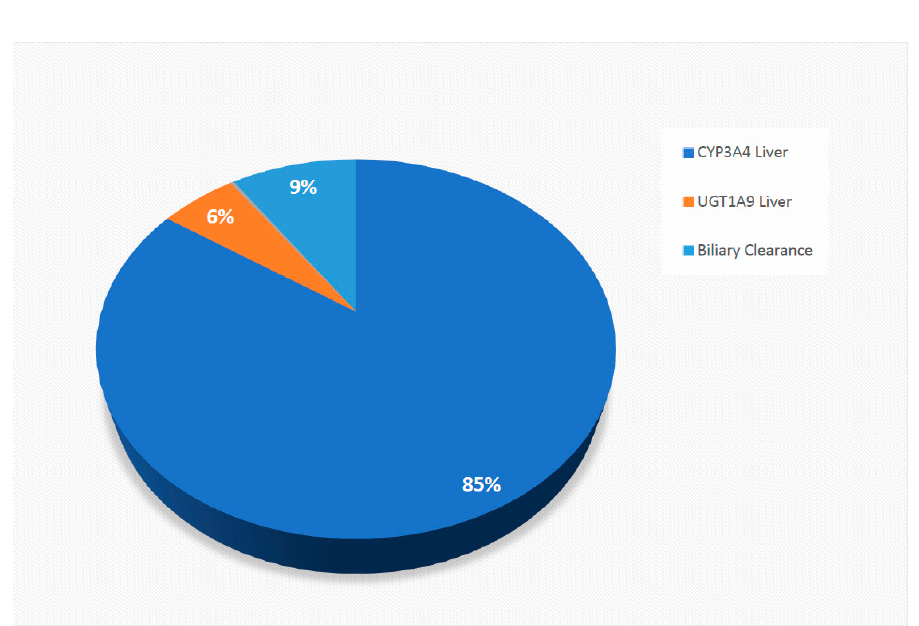
Figure 4. The pie chart demonstrated the relative contribution of CYP and UGT to simulated soraf- enib elimination based on the predicted